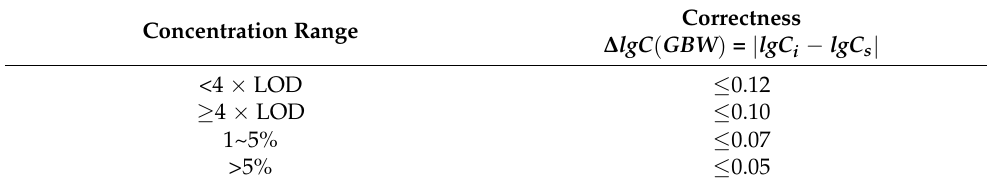
Note: 1 means in range, 0 means out of range. Table A5. The correctness of the CRM.